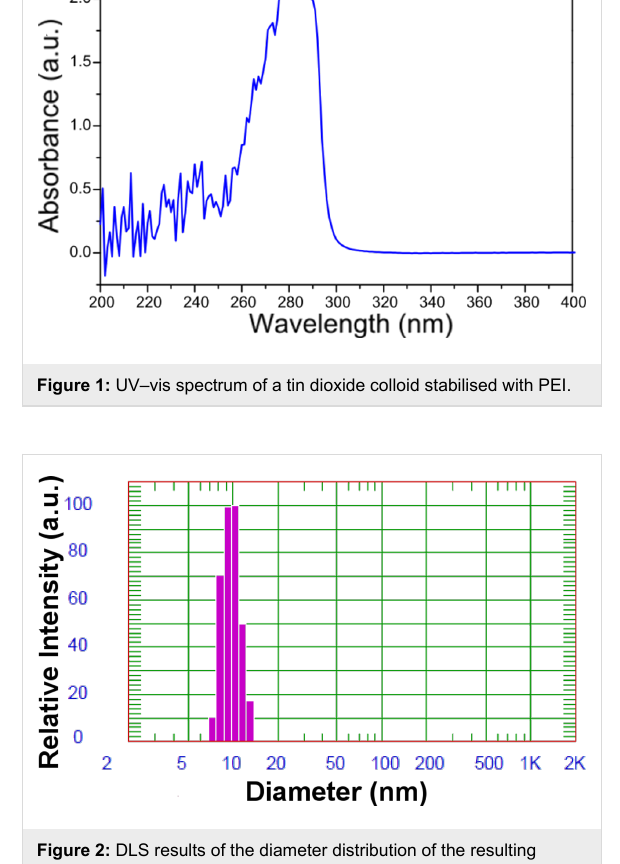
ence between peak intensities corresponding to crystallo- graphic planes (110), (101) and (211) and all are almost equally dominant (Figure 3). The average crystallite size of SnO